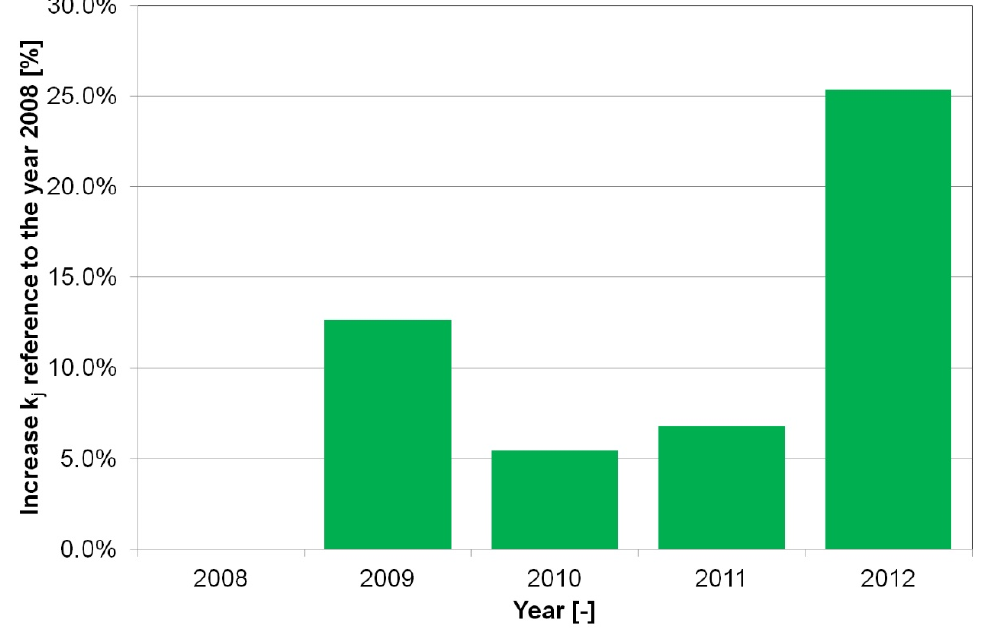
Figure 5. Increase in the value of discounted unit cost k j of energy generation in an optimised WPP system without energy storage with reference to the year with best wind conditions.